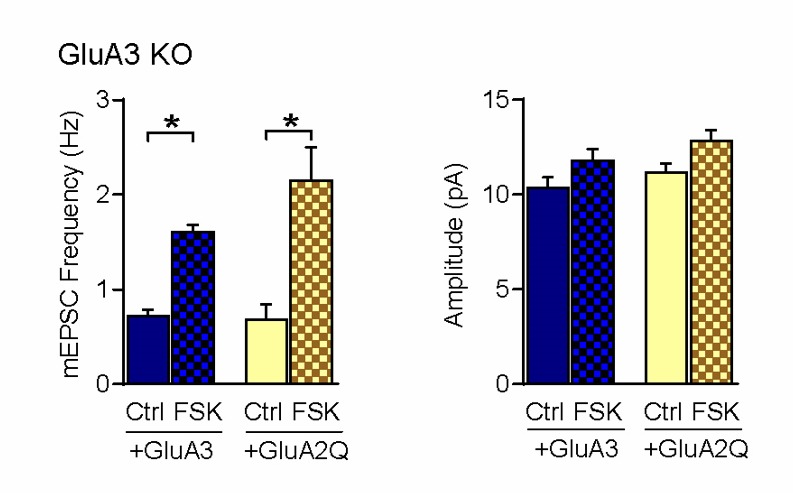
mEPSC frequency and amplitude of GluA3-deficient neurons, infected with GFP-GluA3 (blue) or GFP-GluA2Q (yellow) in the absence (even) or presence (blocked bar) of forskolin.